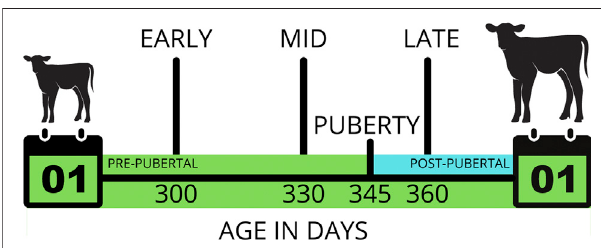
FIGURE 1 | An example of interval censoring for “ age at puberty ” . If this animal was observed daily, it would be recorded as attaining puberty at 345 days old. However, if the herd was observed only three times (early, mid andlate),whenthisanimalwas300,330and360 daysold,respectively, its phenotype would fall within the bounds of 330 – 360